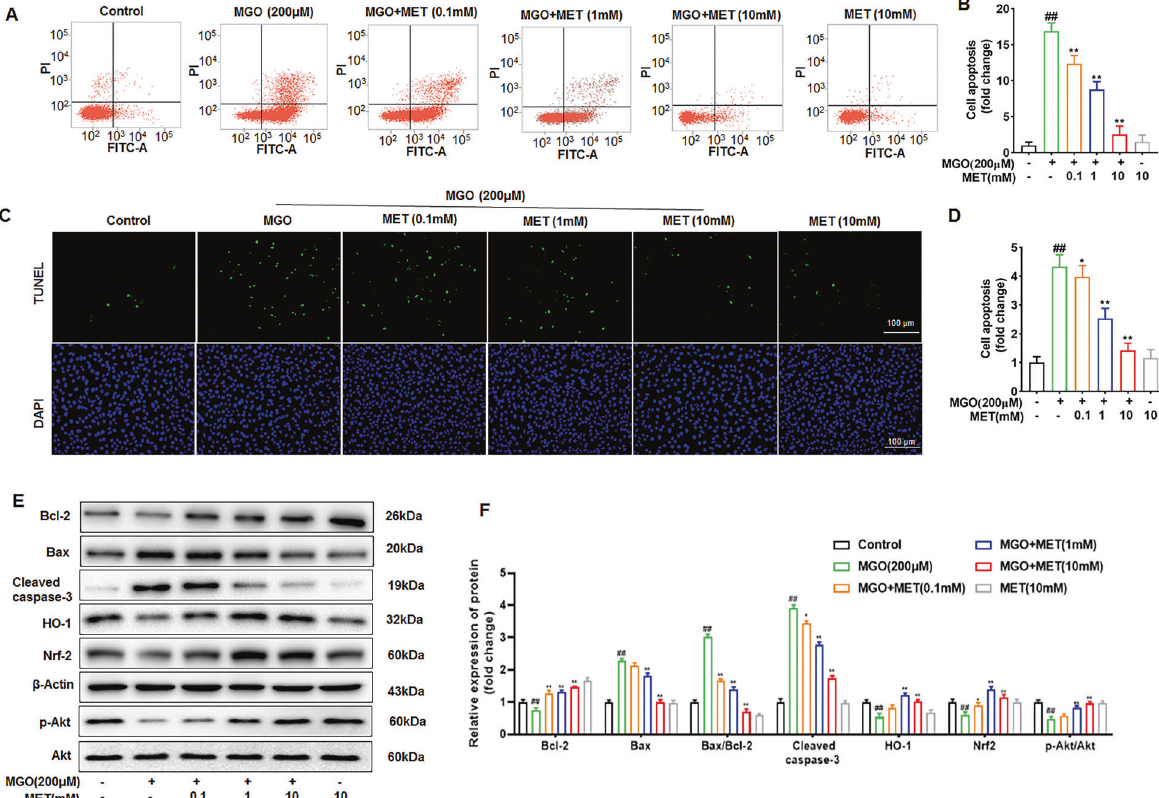
Fig. 1 Suppression of MGO-induced apoptosis by MET. Cells were treated with different concentrations of MET (0, 0.1, 1, and 10 mM) for 2 h prior to being exposed to 200 μ M MGO for 24 h. A , B Cells were trypsinized and stained with Annexin V-FITC and PI for 20 min. Apoptosis was analyzed by fl ow cytometry, and a representative image of the cell population distribution is displayed. C , D Cell apoptosis was examined by the TUNEL assay. Representative images of cell apoptosis are shown. Scale bars, 100 μ m. The number of TUNEL-positive nuclei per fi eld was counted in fi ve randomly micrographs for each sample. Positive cells were counted, and quantitative assessment of quadruplicate cell apoptosis experiments was performed. E , F The effects of MET on MGO-induced changes of apoptosis-related proteins of Bax, Bcl-2, and cleaved caspase-3, as well as oxidation-related proteins of Nrf2 and HO-1 were examined by western blotting. β -Actin was used as a loading control. Moreover, the phosphorylated and total expression levels of Akt were also investigated by western blotting. Bax/Bcl-2 ratio quanti fi ed by densitometry and calculated with reference to β -Actin. All graphs correspond to the blots above them and represent densitometric analyses of three independent experiments; data are expressed as the mean ± SD. ## p < 0.05 vs. Control, * p < 0.05 vs . MGO, ** p < 0.01 vs.